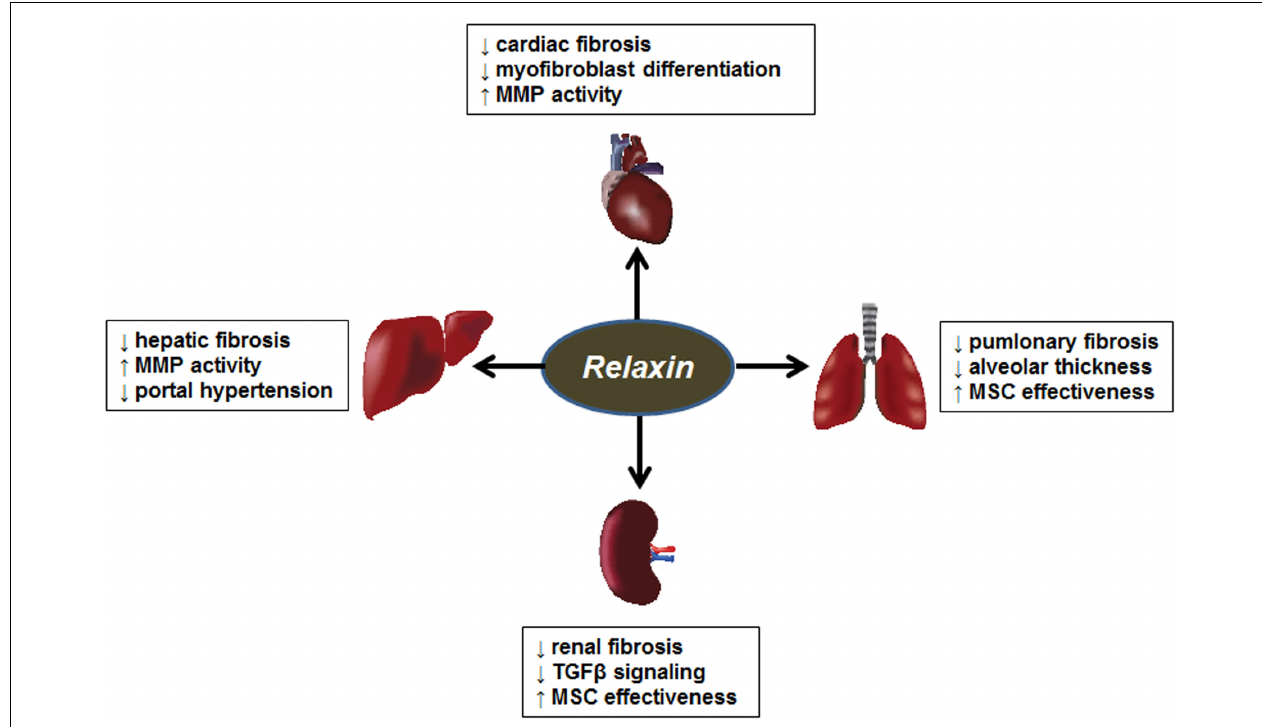
FIGURE 3 | Antifibrotic effects of relaxin. Summary of the antifibrotic effects of PPAR α , PPAR γ , and PPAR β / δ agonists in models of cardiac, hepatic, renal and pulmonary fibrosis. MMP, matrix metalloproteinase; MSC, mesenchymal stem cells.